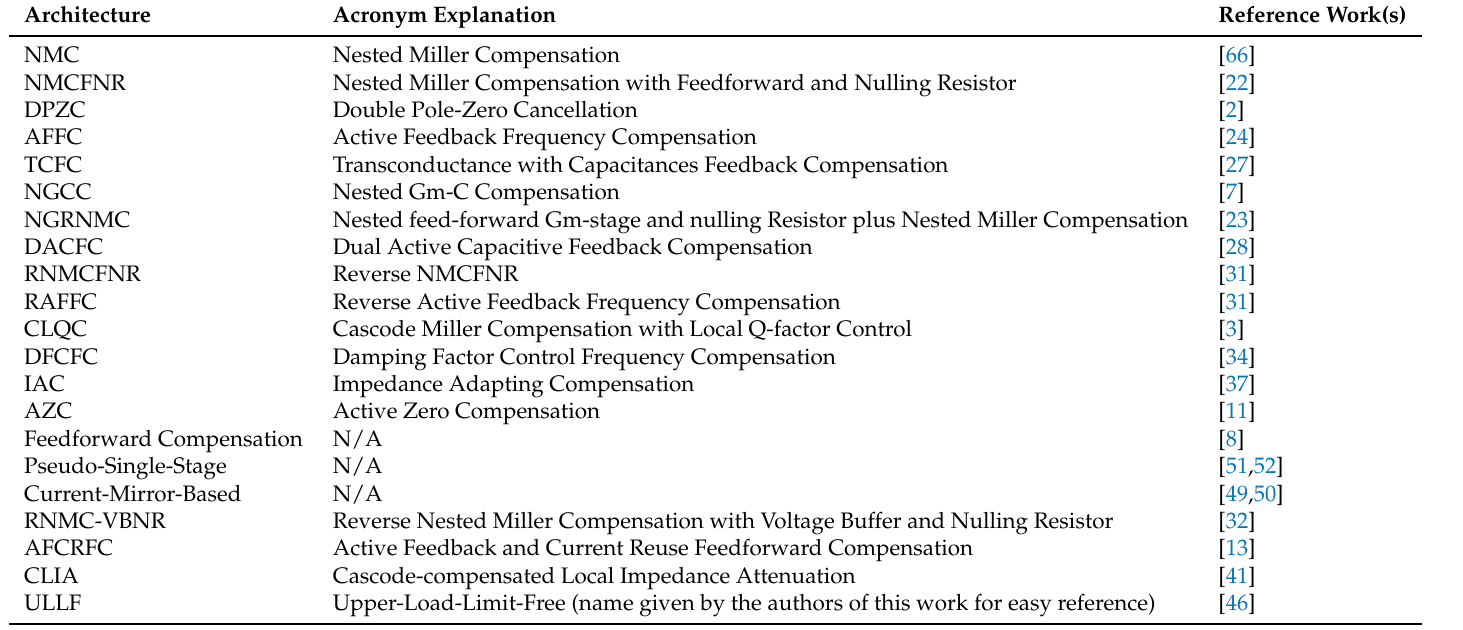
Table 5. Explanation and citations for the acrchitecture acronyms in Figures